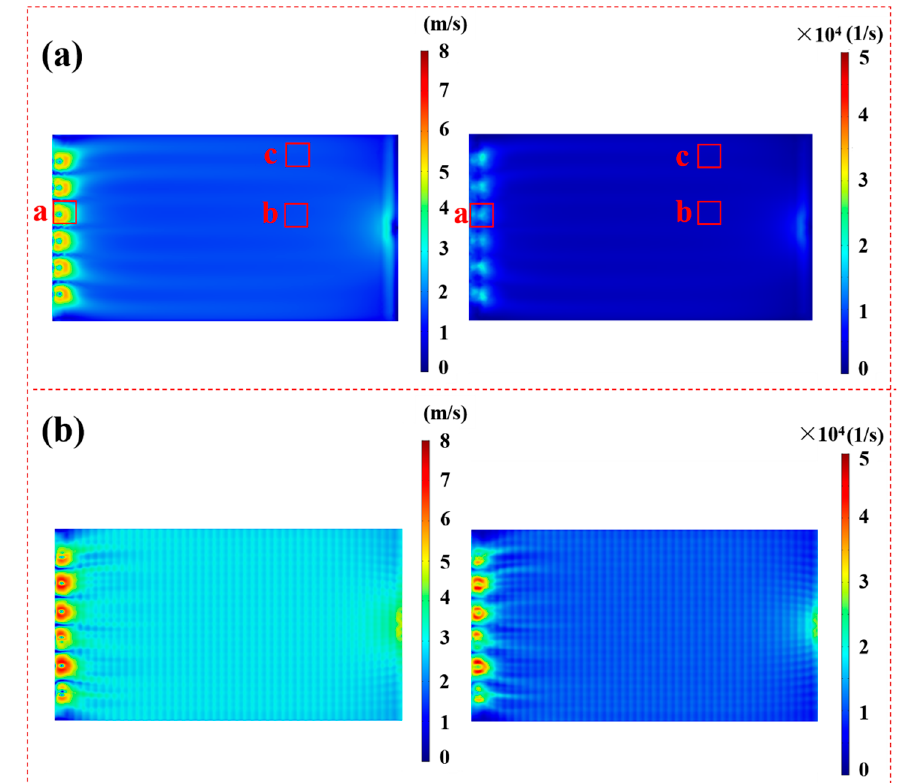
Membranes 2021 , 11 , x FOR PEER REVIEW Figure 7. Velocity and shear rate profiles in the membrane ( a ) without the turbulence promoter and ( b ) with the turbulence promoter (inlet velocity = 8 m/s).